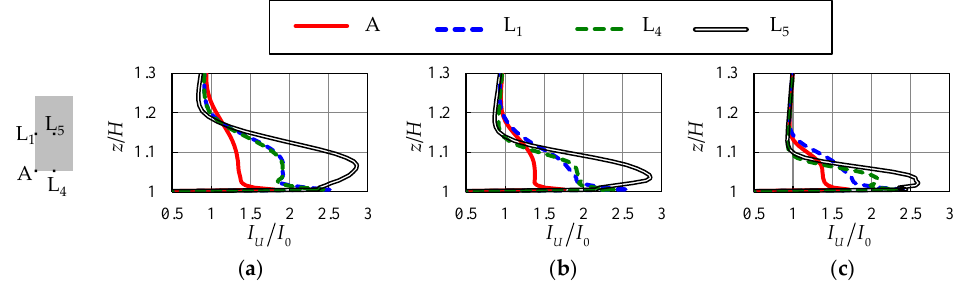
Figure 12. Vertical profiles of turbulence intensity rations at representative locations on the roof, in the case of no prevailing wind direction. ( a ) HAR = 1.00; ( b ) HAR = 0.50; ( c ) HAR = 0.25. The bottoms of the height ranges of the favorable wind conditions where I U / I 0 ≤ 1 and U ̅ U 0 ⁄ > 1 decrease with a decrease in HAR. At L 5 when HAR = 1.0 or at L 4 when HAR ≤ 0.5, the bottom of the height range of favorable wind conditions is lowest; the bottoms of the height ranges at these locations are almost the same when HAR = 0.5 and 0.25.